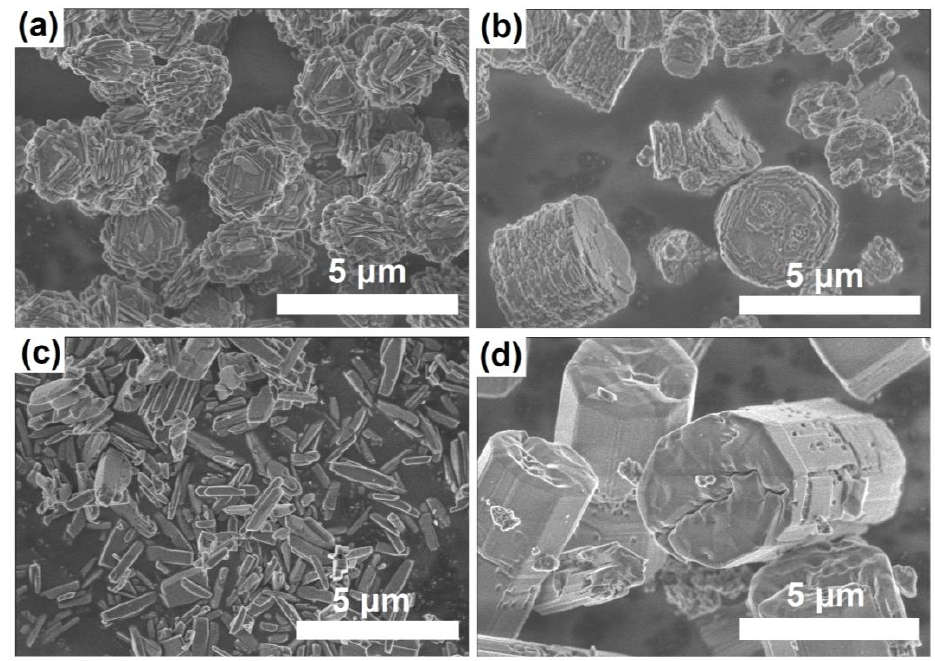
Figure 6. SEM images of molecular sieves: ( a ) Sample IF-iAl-90; ( b ) Sample IF-iAl-130; ( c ) Sample IF-SB-90; ( d ) Sample IF- SB-130.